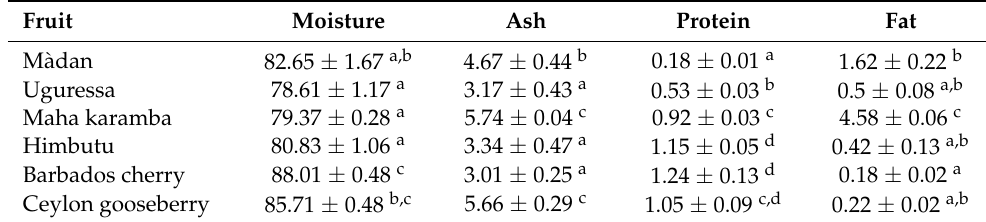
Table 1. Proximate composition (% of fresh) of six underutilized fruits.